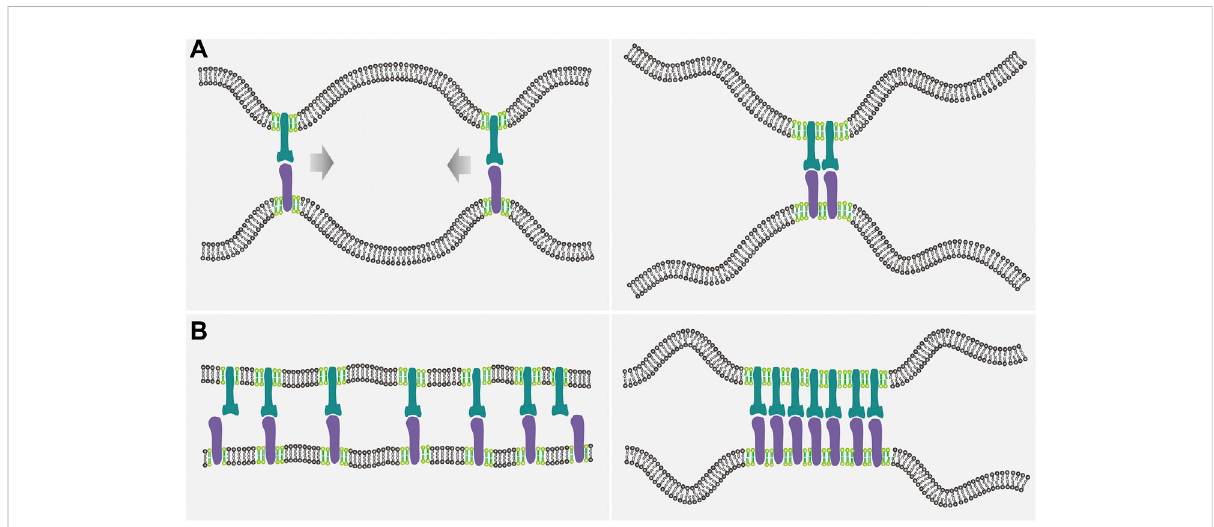
FIGURE 1 Illustrationof theinterplay between thereceptor-ligand bindingand thelipid domain formation in thecase of mobile receptors and ligands. (A) Sincethe fl exiblemembranescanadoptmorecon fi gurationswhenthereceptor-ligandcomplexesareclosetogether(leftpanel)thanfarapart(right panel), thermal undulations of the membranes induce an effective, entropic attraction between the receptor-ligand complexes, which in turn promotes the coalescence of lipid rafts (light green) by means of the protein-raft association. (B) Raft coalescence leads to aggregation of the raft-associatedreceptors(darkgreen)andligands(purple),andthereforedecreasesthecon fi gurationalentropylossofthe fl exiblemembranesupon the receptor-ligand binding, enhancing the receptor-ligand binding af fi nity and